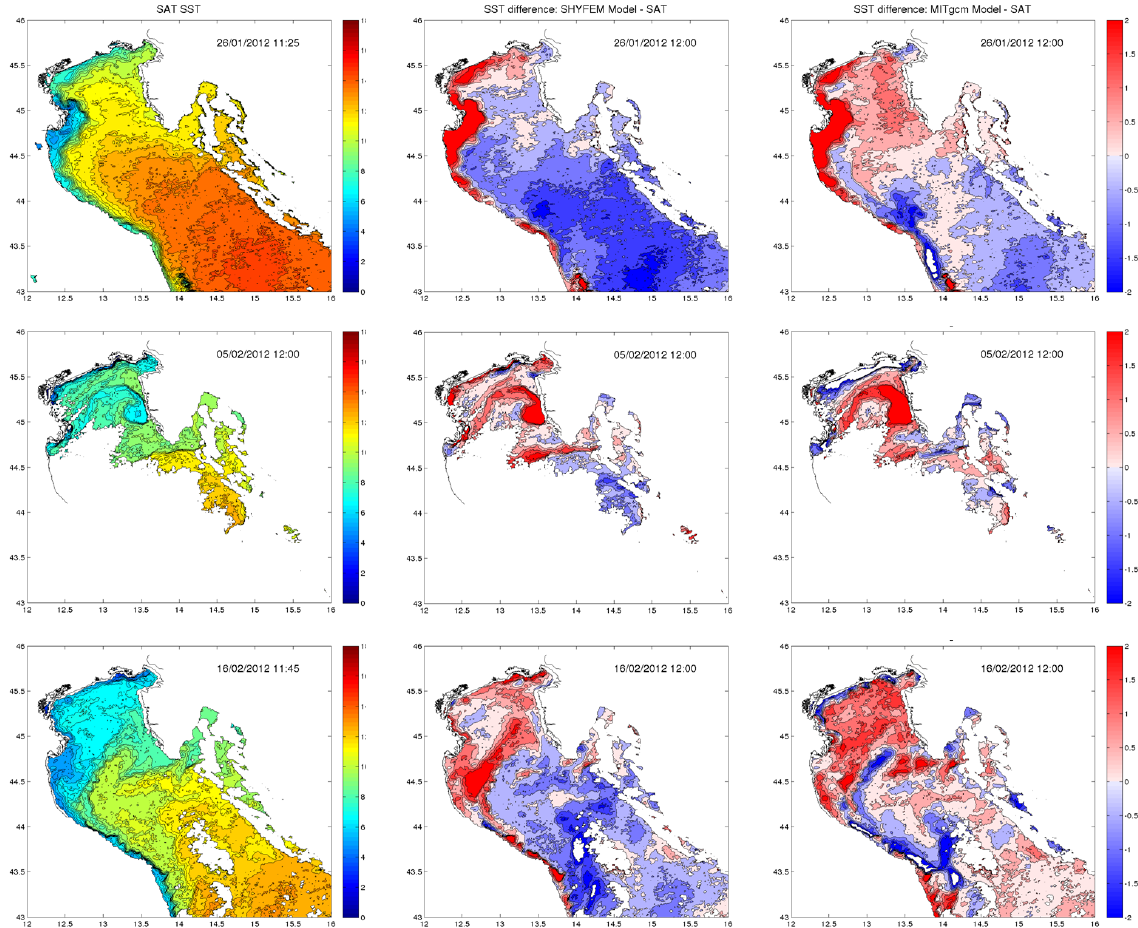
Figure 6. MODIS SST images (left column) and bias maps showing the difference between model SST from MODIS satellite observations for SHYFEM (center column) and MITgcm (right column), for times before, during, and just after the dense water event, namely 26 January (top row), 5 February (center row), and 16 February 2012 (bottom row). Units are [ ◦